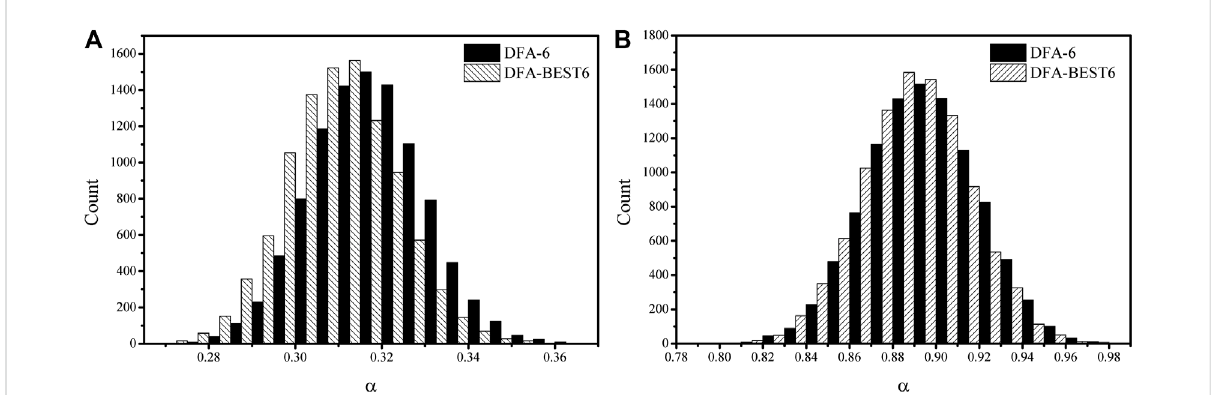
FIGURE 3 The histograms of scaling exponents simulated by DFA-6 and DFA-BEST6 for time series with actual scaling exponents of 0.3 (A) and 0.9 (B) ,